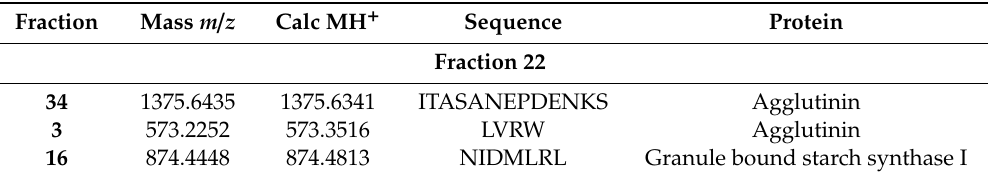
Table 3. Peptides identified in the most active fractions from amaranth hydrolysate and their corresponding protein